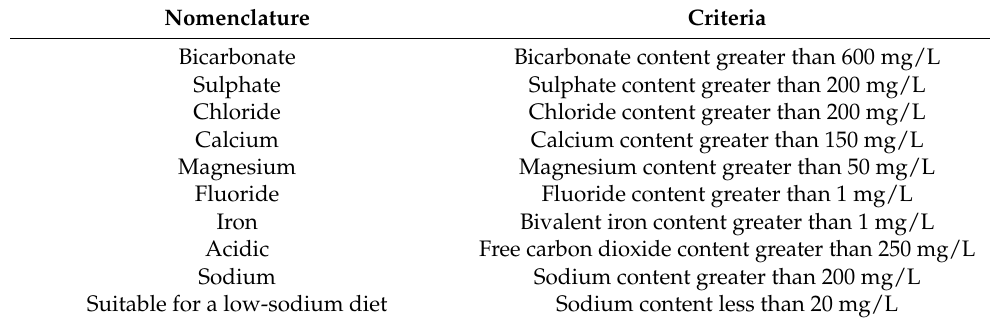
Table 1. Nomenclature of natural mineral waters classified according to their prevailing mineral